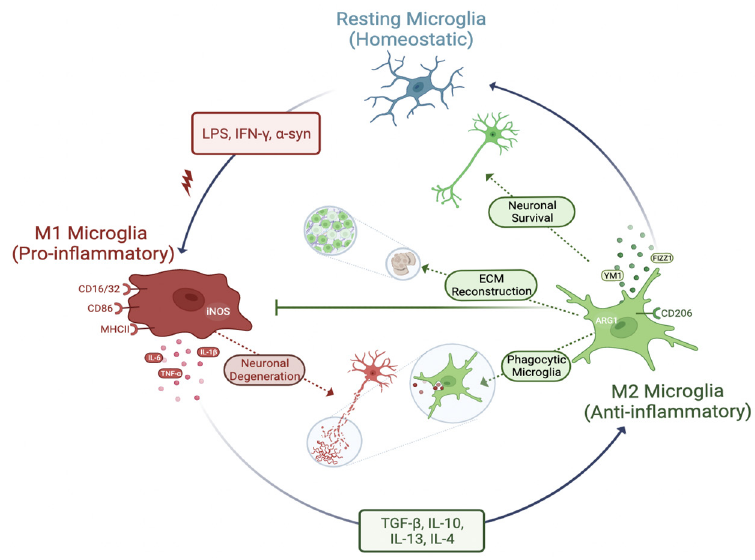
Figure 1. M1 and M2 microglia phenotypes. Under physiological circumstances, microglia exhibit the homeostatic microglia phenotype. Depending on the environment in which they are reactive and the factors in which they are stimulated, they can change into “pro-inflammatory (M1)” or “anti-inflammatory (M2)” phenotypes. Microglia play important roles in maintaining the health of neurons, including pruning and remodeling synapses, controlling myelination, and removing pathological proteins that are misfolded through neurogenesis and phagocytosis. Microglia are also responsible for maintaining the homeostasis of brain tissue. Additionally, depending on the type of activation, microglia secrete numerous trophic factors, cytokines, and chemokines to aid in neuronal survival. Pathogenic molecules, such as LPS and/or IFN, or protein aggregates, such as α -syn, stimulate microglia into the pro-inflammatory phenotype, which then releases inflammatory molecules, such as ROS and other pro-inflammatory cytokines, including IL-1 β , iNOS, TNF α , and others. Persistent exposure of microglia to these inflammatory mediators may result in neuronal damage. Contrarily, mediators, such as TGF- β , IL-4, IL-10, and IL-13, induce the M1 to M2 transition. The M2 phenotype of microglia contribute to the processes in phagocytosis, ECM rebuilding, and neuronal survival by secreting such factors as Ym1 and